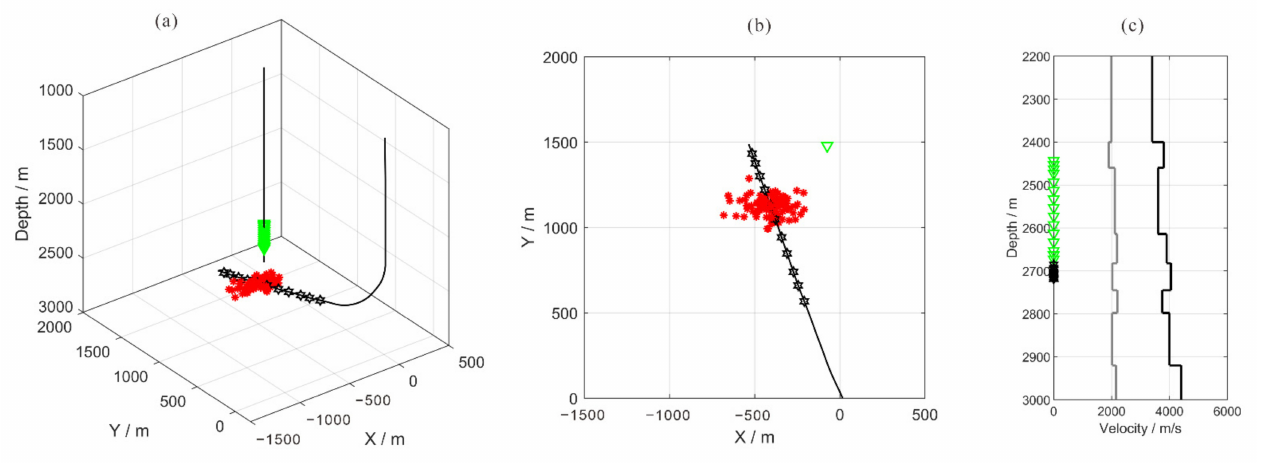
Figure 5. Layout and location of a real case microseismic monitoring system: the green triangles represent receivers, the black stars represent 11 fracturing sections, and the red stars represent the 100 microseismic event locations used to generate synthetic data. ( a ) 3-D view; ( b ) planar view; ( c ) the velocity model. Black and gray lines represent P and S wave velocities, respectively.